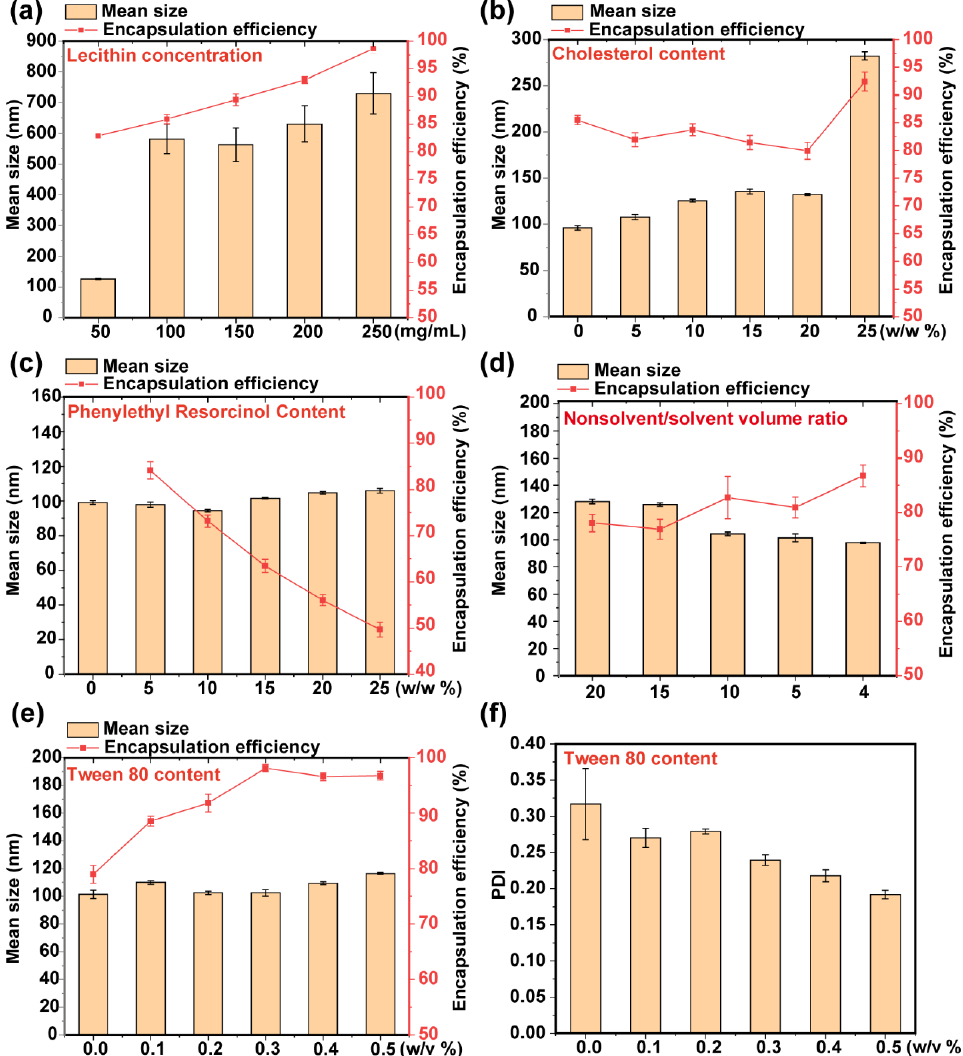
Figure 2. Effect of different factors on the size and EE of PR-NLPs; one factor was changed while the other factor was kept constant at a time. The effect of ( a ) lecithin concentration; ( b ) cholesterol content; ( c ) phenylethyl resorcinol content; ( d ) the volume ratios of nonsolvent and solvent; ( e ) Tween 80 content; ( f ) Effect of the Tween 80 on the PDI of PR-NLPs (n = 3, mean value ± SD).